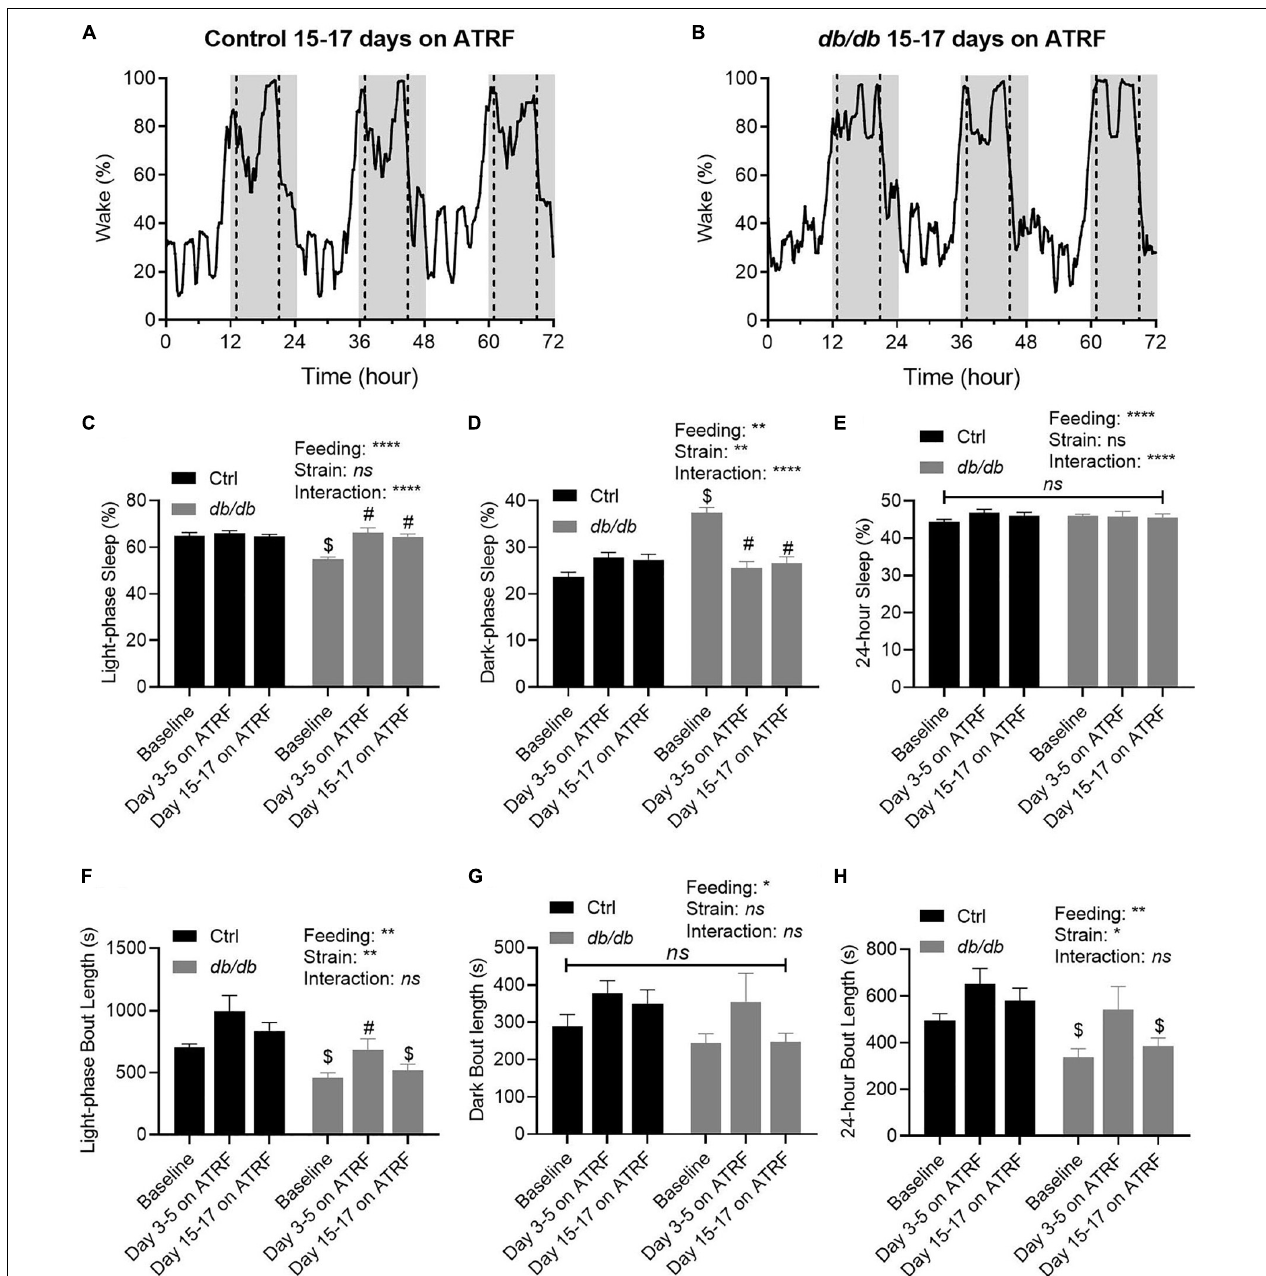
FIGURE 4 | Time-dependent improvements of sleep-wake profile by ATRF in the control and db/db mice. Representative sleep-wake profiles in the control (A) and db/db mice (B) with 15–17 days of ATRF. The gray box indicates the dark-phase. The dotted vertical line indicates the time when food was added or withdrawn. (C–E) Average sleep time percent at baseline (ALF), 3–5 days and 15–17 days of ATRF during the light-phase (C) , dark-phase (D) , and over 24-h (E) . (F–H) Average bout length at baseline (ALF), 3–5 days, and 15–17 days of ATRF during the light-phase (F) , dark-phase (G), and over 24-h (H) . Control, n = 6–8; db/db , n = 6–7. $ p < 0.05 when compares with control. # p < 0.05 when compares with baseline. ∗ p < 0.05; ∗∗ p < 0.01; ∗∗∗∗ p < 0.0001; ns , no